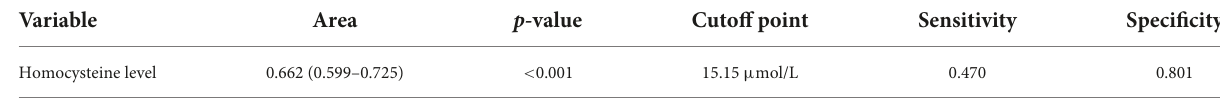
TABLE 4 The areas under ROC curve, sensitivity, and specificity of the optimized cutoff points for homocysteine level as a biomarker of CKD. Variable